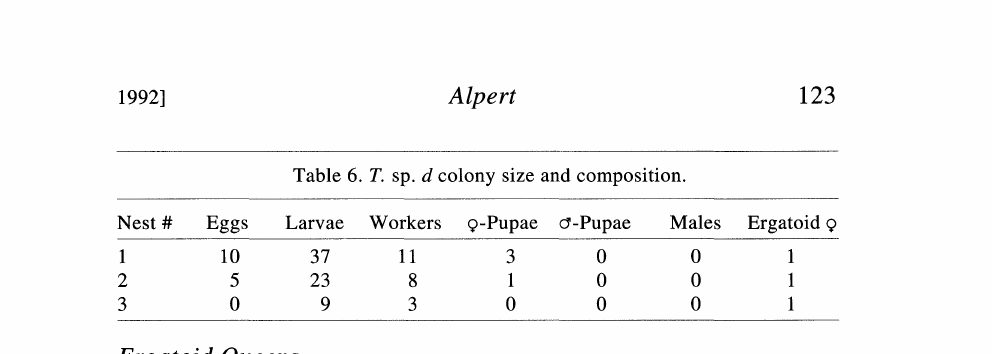
Table 6. T. sp. d colony size and composition.